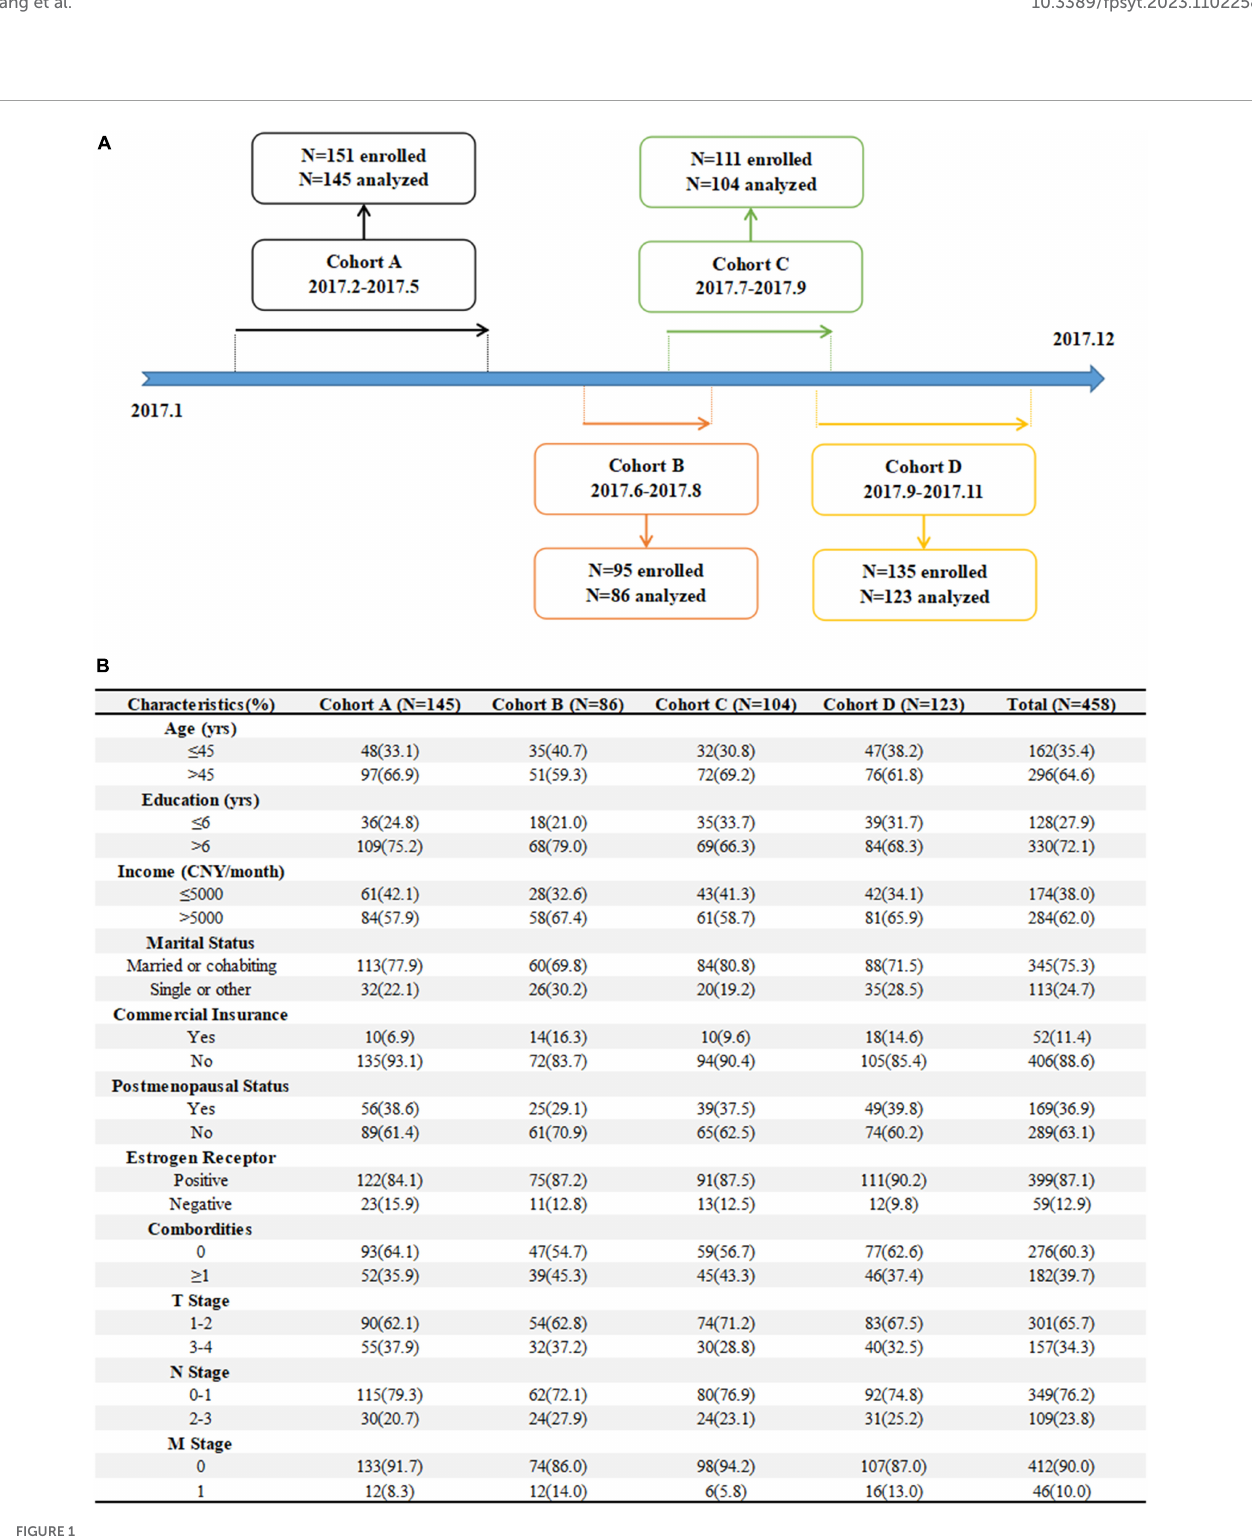
deviation) of change was defined as Decreased (outcome = 1) and other groups were defined as Non-decreased (outcome =